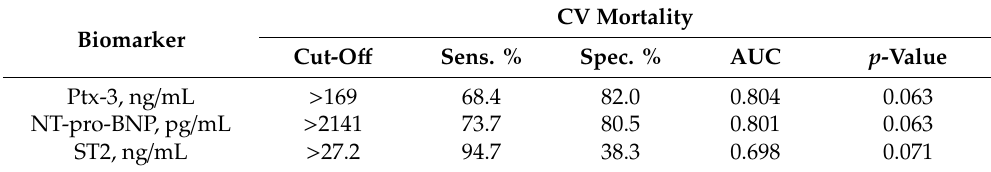
Table 3. Biomarker cut-off values for CV mortality in a two-year FU after STEMI ( p < 0.1). Biomarker